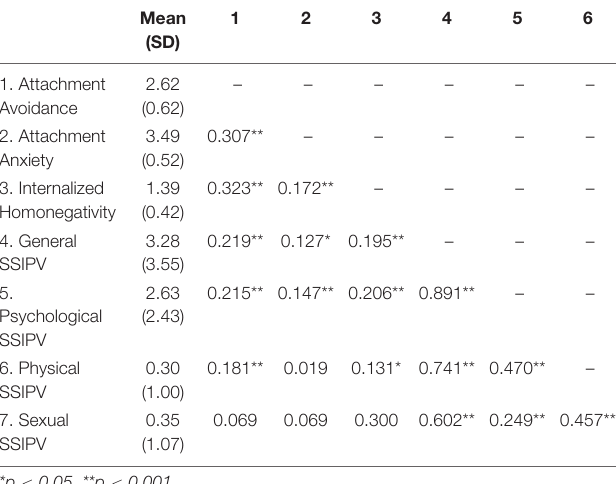
TABLE 3 | Descriptive statistics and bivariate correlations.